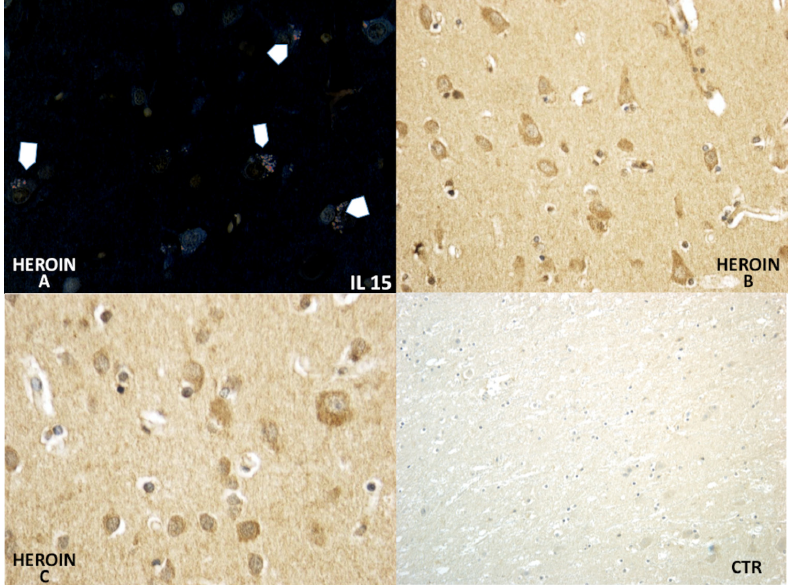
Figure 1. IL-15 showed a wide positive reaction in neurons, expressed by red dots in the cytoplasm [head-arrows in ( A) ]; associated to vascular ( B ); and oligodendrocyte positivity ( C ). CTR negative control case.